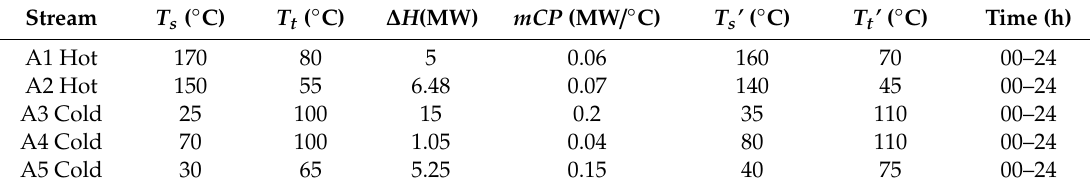
Table 3. Stream data for Industrial Plant B with ∆ T min, pp = 10 ◦ C (modified from Jamaluddin et al. [27]). Stream